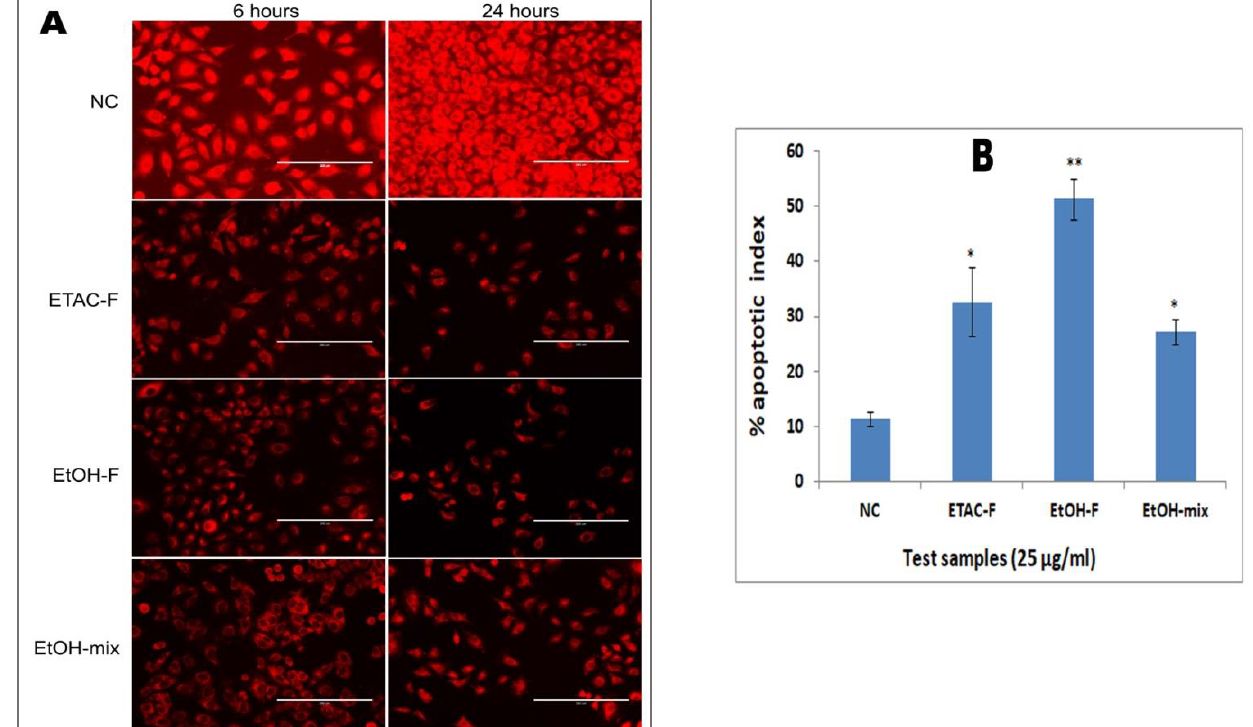
Figure 6. ( A ) The photo-micrographs call attention to the capability of the extracts to interrupt the potential of the mitochondrial membrane. ( B ) Graphical illustration of percentage apoptotic indices.